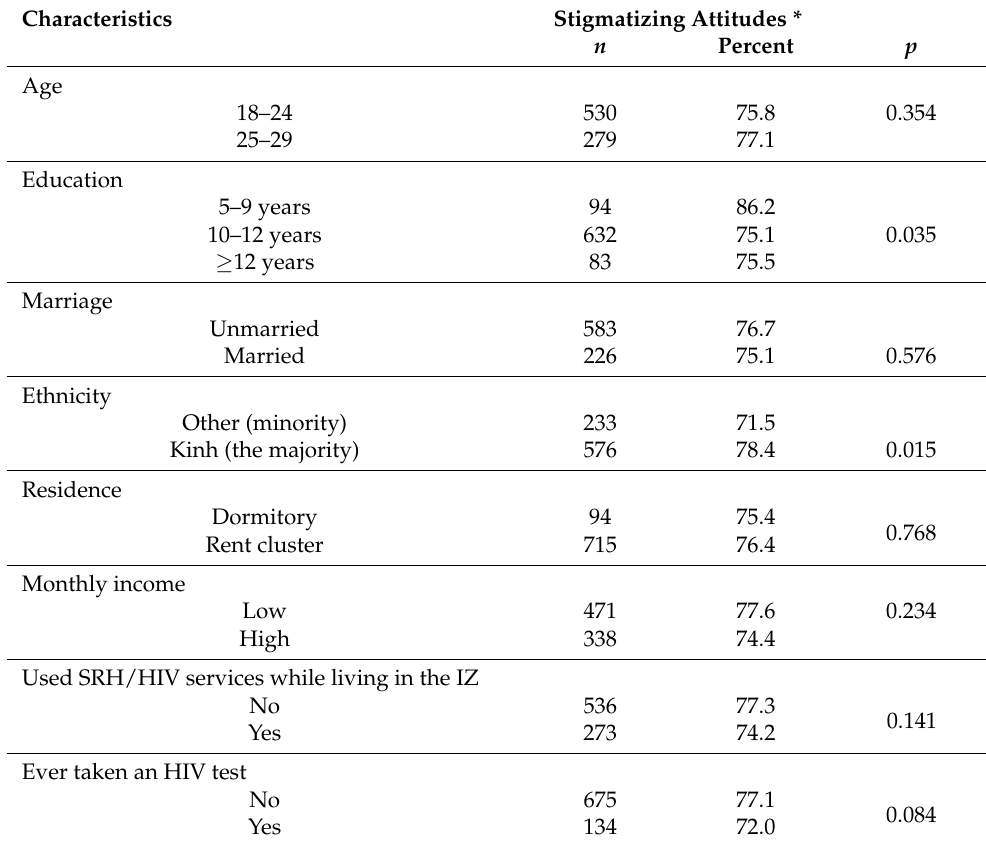
Table 3. Stigmatizing attitudes by demographic characteristics among those who possessed stigma- tizing attitudes toward